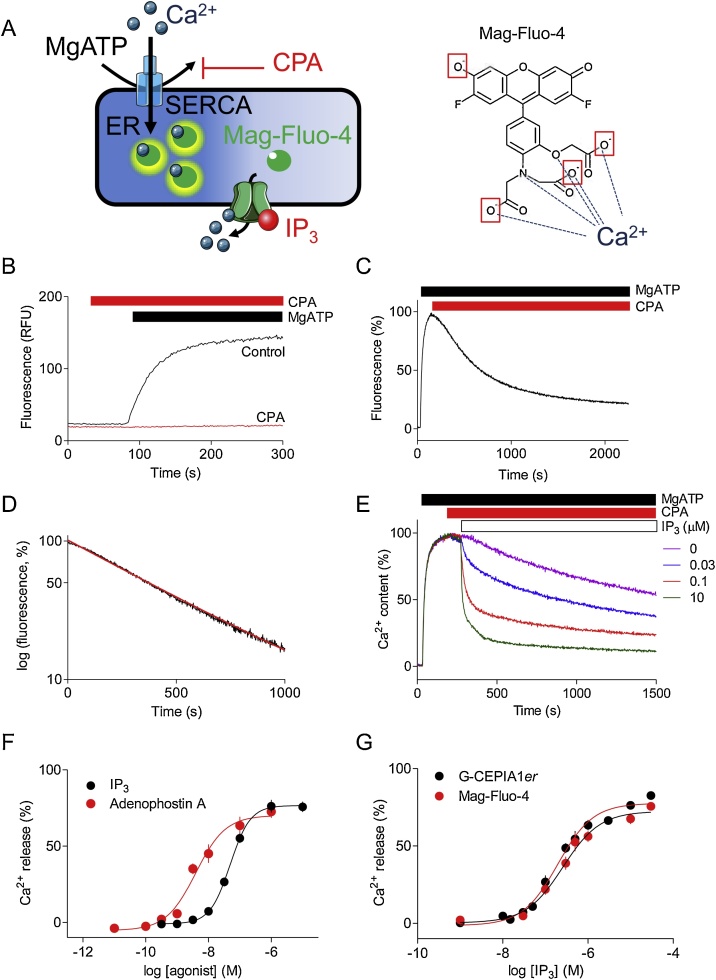
Mag-Fluo-4 within the ER can reliably measure Ca2+ uptake and release. (A) Principle of the assay and structure of Mag-Fluo-4 highlighting the groups esterified in Mag-Fluo-4 AM (boxes) and the substituents that coordinate Ca2+ (arrows) [40]. (B) The increase in fluorescence from Mag-Fluo-4 after addition of MgATP (1.5 mM) to permeabilized DT40-IP3R1 cells is abolished by CPA (10 μM). Traces are typical of 3 independent experiments. RFU, relative fluorescence units. (C) Addition of CPA (10 μM) to permeabilized DT40-IP3R1 cells loaded to steady state with Ca2+ unmasks a slow Ca2+ leak. Trace is the average of 3 independent experiments. (D) Fluorescence after addition of CPA plotted semi-logarithmically (mean ± SEM, n = 3). (E) Permeabilized DT40-IP3R1 cells loaded with Mag-Fluo-4 AM were stimulated with MgATP (1.5 mM) to fuel Ca2+ uptake, CPA (10 μM) to inhibit SERCA, and IP3 as indicated. Traces are typical of 3 experiments. (F) Concentration-dependent effects of IP3 and adenophostin A (mean ± SEM, n = 3, each with 3 replicates). (G) Concentration-dependent effects of IP3 on Ca2+ release from the ER of permeabilized HEK cells stably expressing G-CEPIA1er (HEK- G-CEPIA1er) or loaded with Mag-Fluo-4 AM. Means ± SEM from 6-9 independent experiments, each performed in duplicate. Results are summarized in Table 1.